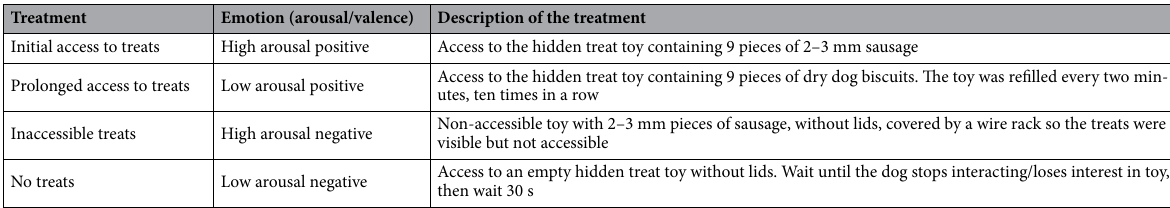
Table 1. Treatments used in experiment 1 that were designed to induce the different emotions.